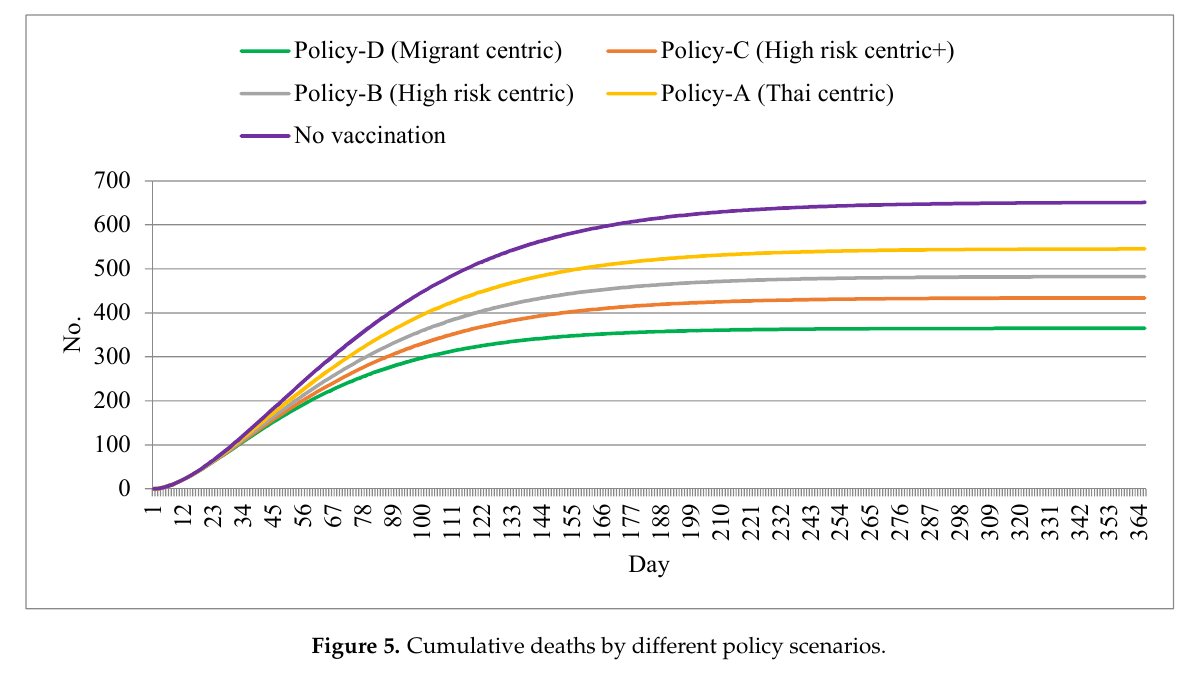
Figure 5. Cumulative deaths by different policy scenarios.